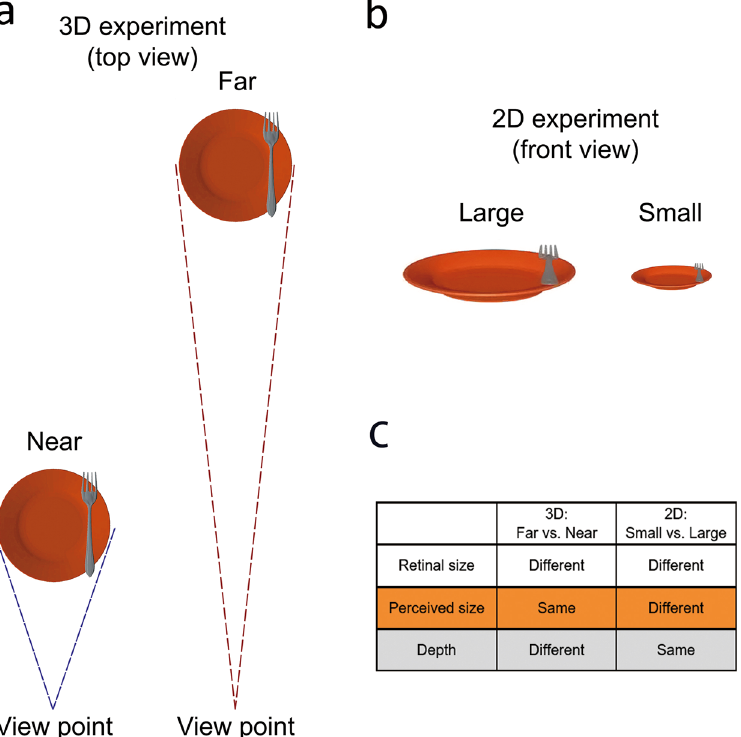
Figure 5. Experimental settings in the present study. ( a ) Top view of the 3D objects in the virtual 3D experiment. ( b ) Visual stimuli in the 2D experiment were exactly the same as the frontal view of the 3D stimuli in the virtual 3D experiment. ( c ) Two major differences (hightlighted) between the 3D and the 2D